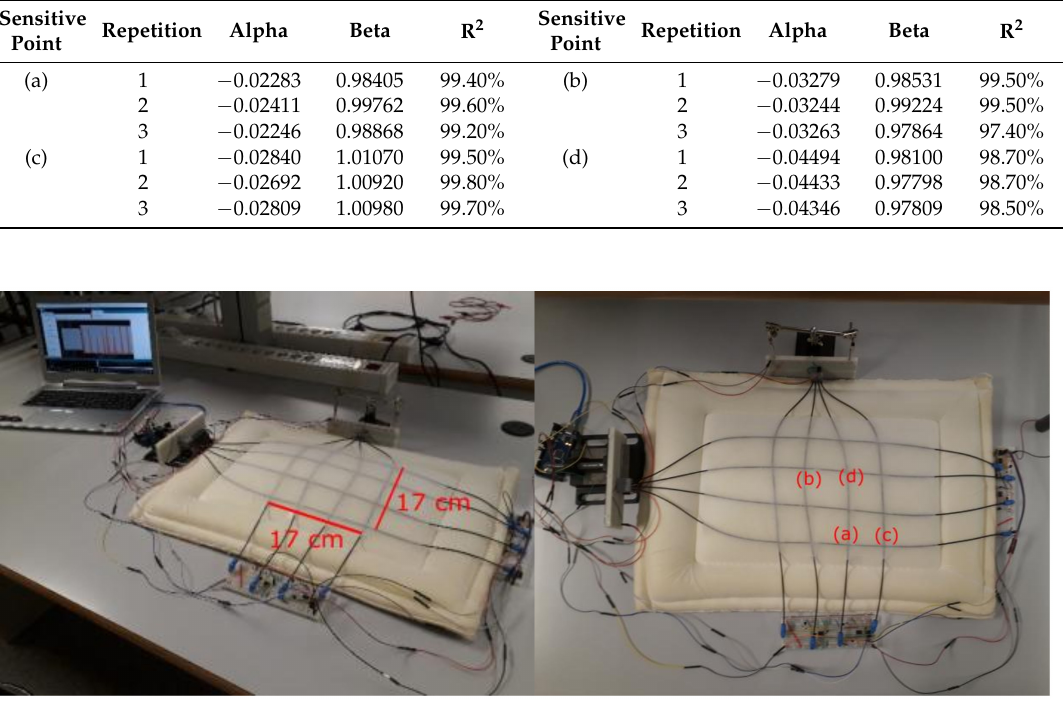
Figure 8. ( a ) Experimental set-up; and ( b ) mattress cover with the integrated POFs, the points tested to measure the static response are circled and